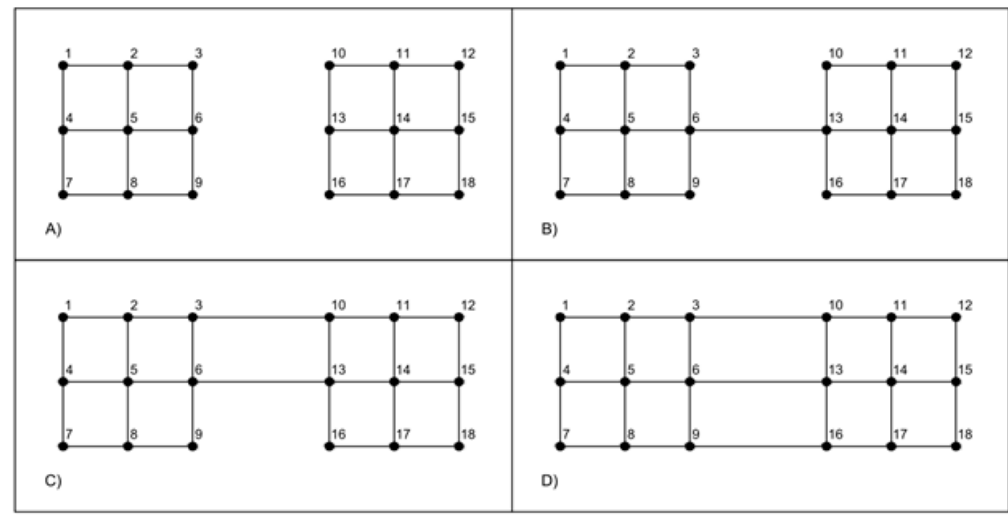
Figure 1. Four layouts of the Example Network with the same number of nodes and a different number of links. A ) two separated subregions; B ) a single edge links the two subregions; C ) two edges link the two subregions; D ) three edges link the two subregions.